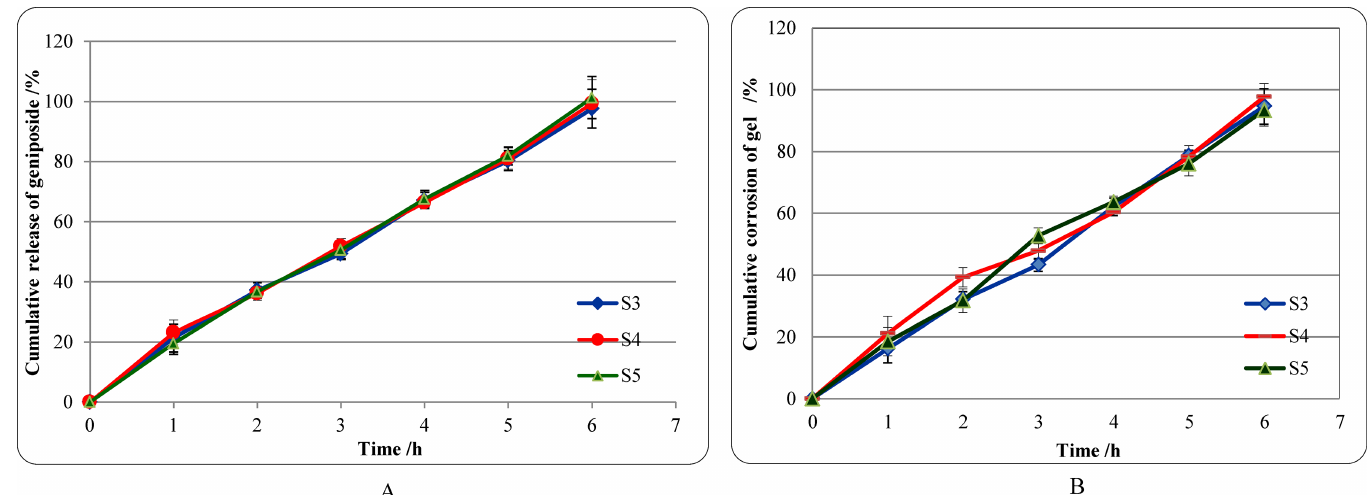
Fig 2. The releasefeaturesof formulation in vitro . (A) Cumulative release of geniposide from the optimizedformulations. (B) Cumulative corrosionof gel of the optimizedformulations.